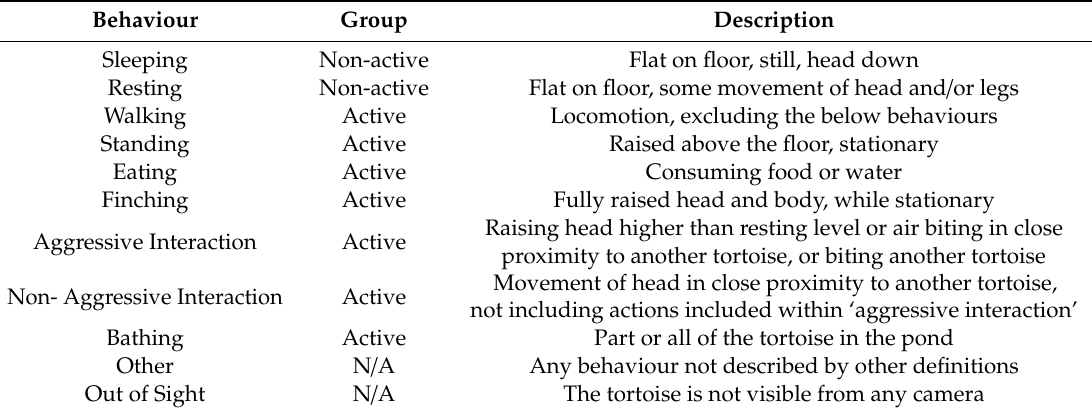
Table 1. An ethogram describing the di ff erent behaviours exhibited by Gal á pagos tortoises and whether they are classed as active or non-active